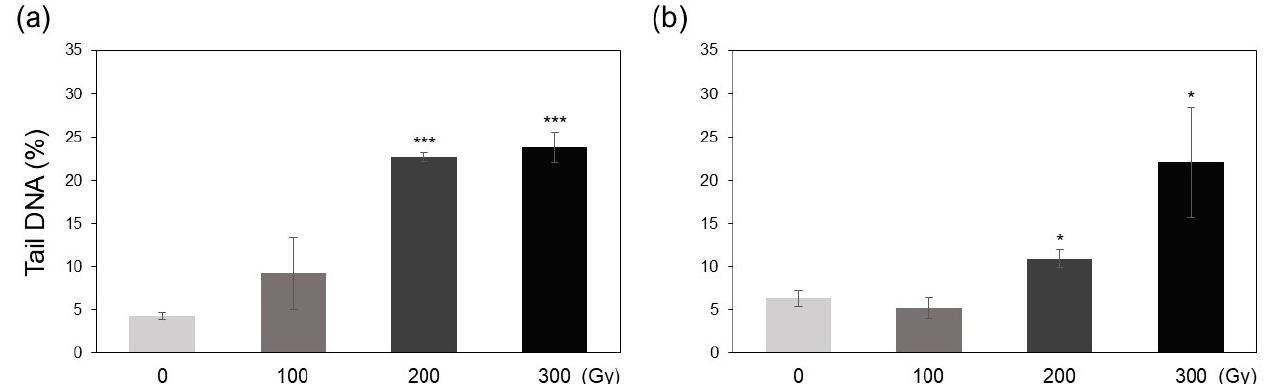
Figure 1. DNA damage induced by acute and chronic gamma irradiation in rice plants. ( a ) Acute irradiation treatments;